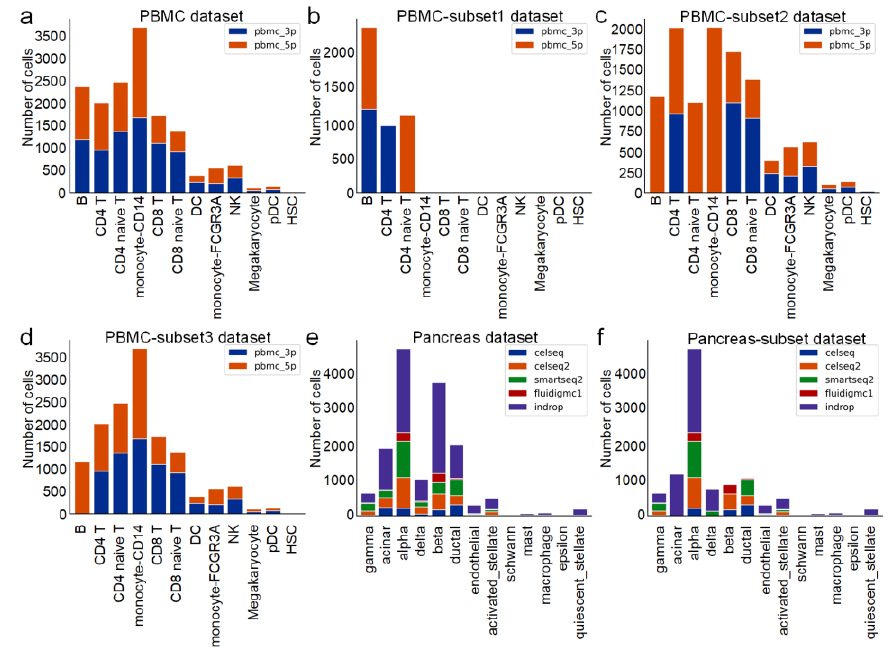
Figure 3. The number of cells in different batches for each dataset. ( a ) PBMC dataset, ( b ) PBMC-subset1 dataset, ( c ) PBMC-subset2 dataset, ( d ) PBMC-subset3 dataset, ( e ) Pancreas dataset, ( f ) Pancreas-subset dataset.